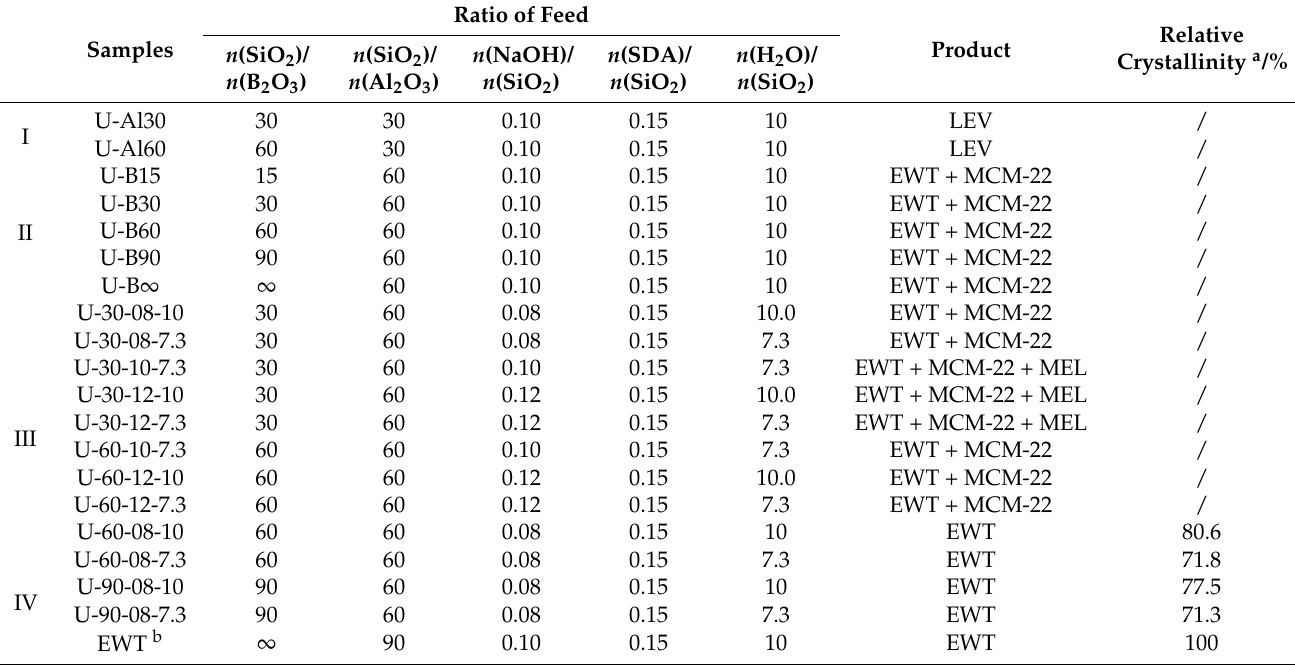
Table 1. The feed ratio of samples by direct synthesis.